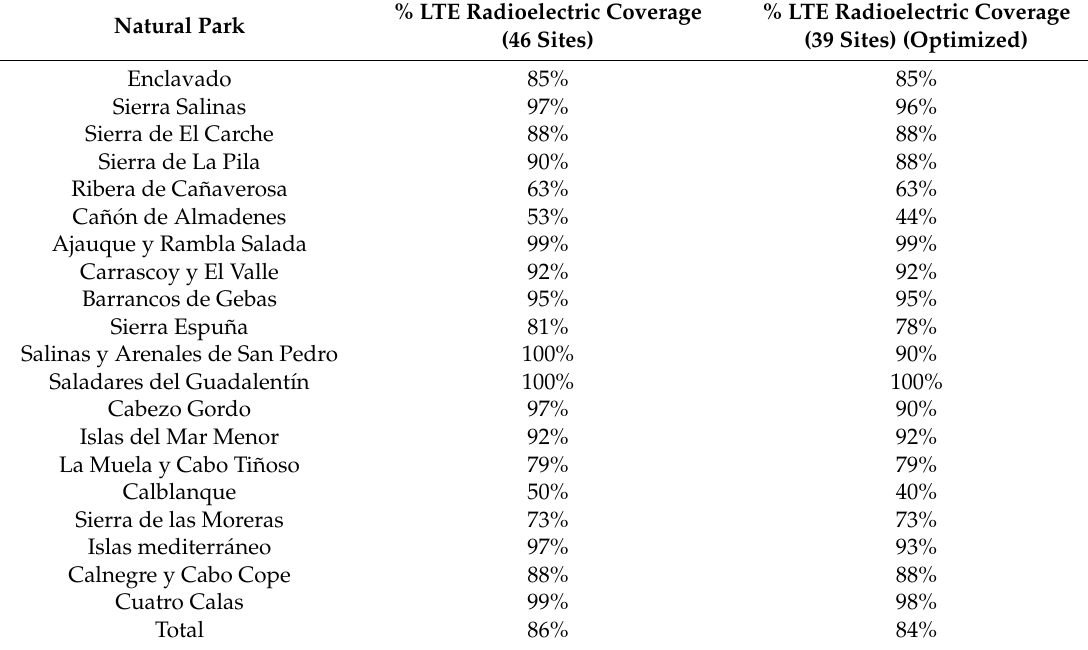
Table 5. Percentage of radioelectric coverage in natural